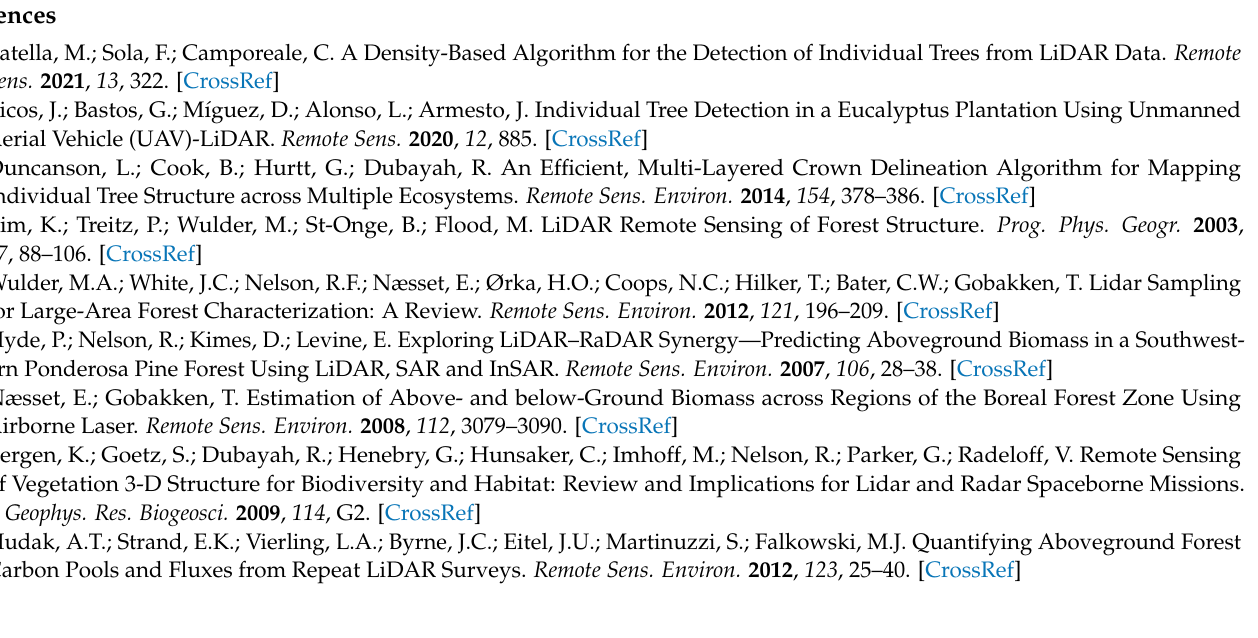
maps in the black walnut stand; Table S1: Tree detection accuracy comparison table; Table S2: t -test for tree heights between single-step HMeanShift using constant (C–H) and dynamic kernels (D–H); Table S3: t -test for tree heights between stepwise approach (C–S) and single-step HMeanShift (C–H) using constant kernel; Table S4: t -test for tree heights between stepwise approach (D–S) and single-step HMeanShift (D–H) using dynamic kernel; Table S5: t -test for crown size between single-step HMeanShift using constant (C–H) and dynamic kernels (D–H); Table S6: t -test for crown size between stepwise approach (C–S) and single-step HMeanShift (C–H) using constant kernel; Table S7: t -test for crown size between stepwise approach (D–S) and single-step HMeanShift (D–H) using dynamic kernel; Table S8: Time efficiency analysis of point cloud based mean shift